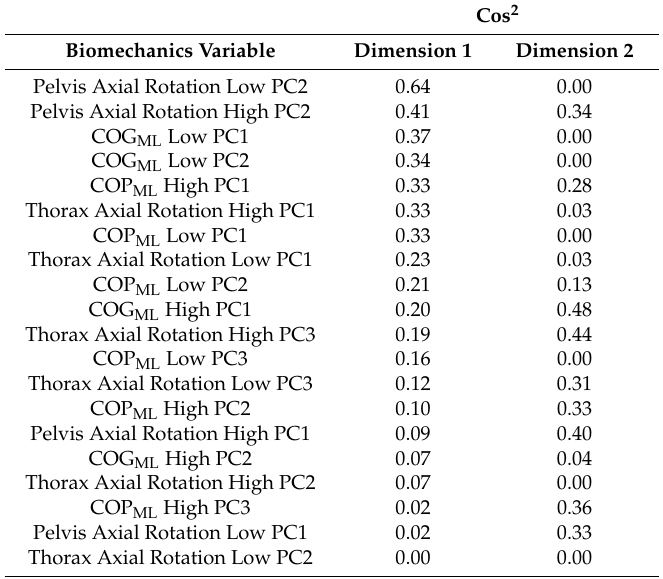
Figure 4. Correspondence analysis of fuzzy coded biomechanics principal components thorax and pelvis axial rotation (AR) low and high (Hi), medial-lateral centre of pressure and gravity (COP ML , COG ML ) low and high. The figure is divided into four quadrants (Q1, Q2, Q3, Q4). Clubhead velocity (CHV) and ball velocity (BV) are included as supplementary points. Table 2. Inertia values (cos 2 ) of contributing fuzzy coded biomechanics variables of dimension one and dimension two of the first factor plane ordered by greatest contribution to dimension